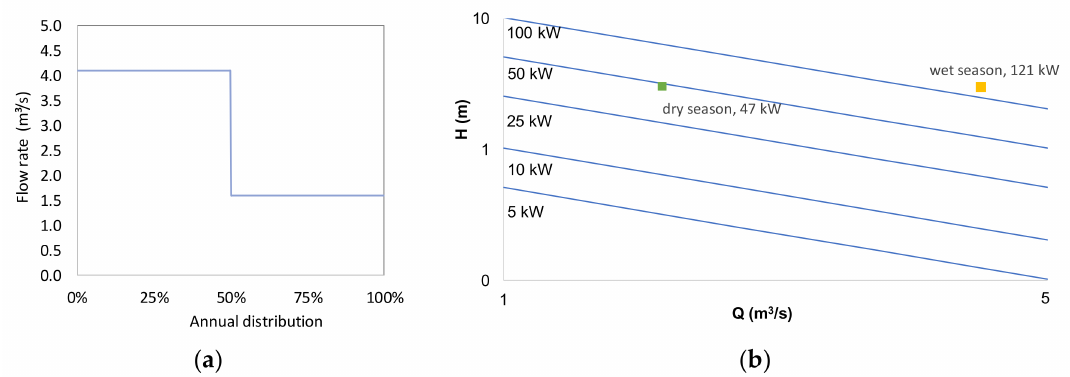
Figure 5. ( a ) Annual distribution of the flow rate; ( b ) curves for potential hydraulic power recovering ( η = 100%).